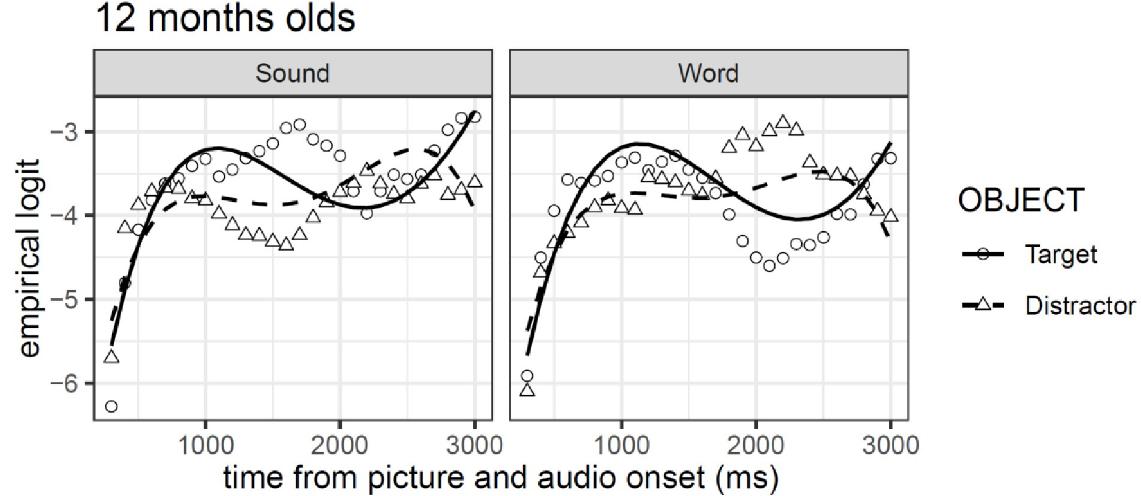
Fig 8. GCA model fit (lines) of empirical logit (points) as a function of object in the visual context and type of auditory stimulus.